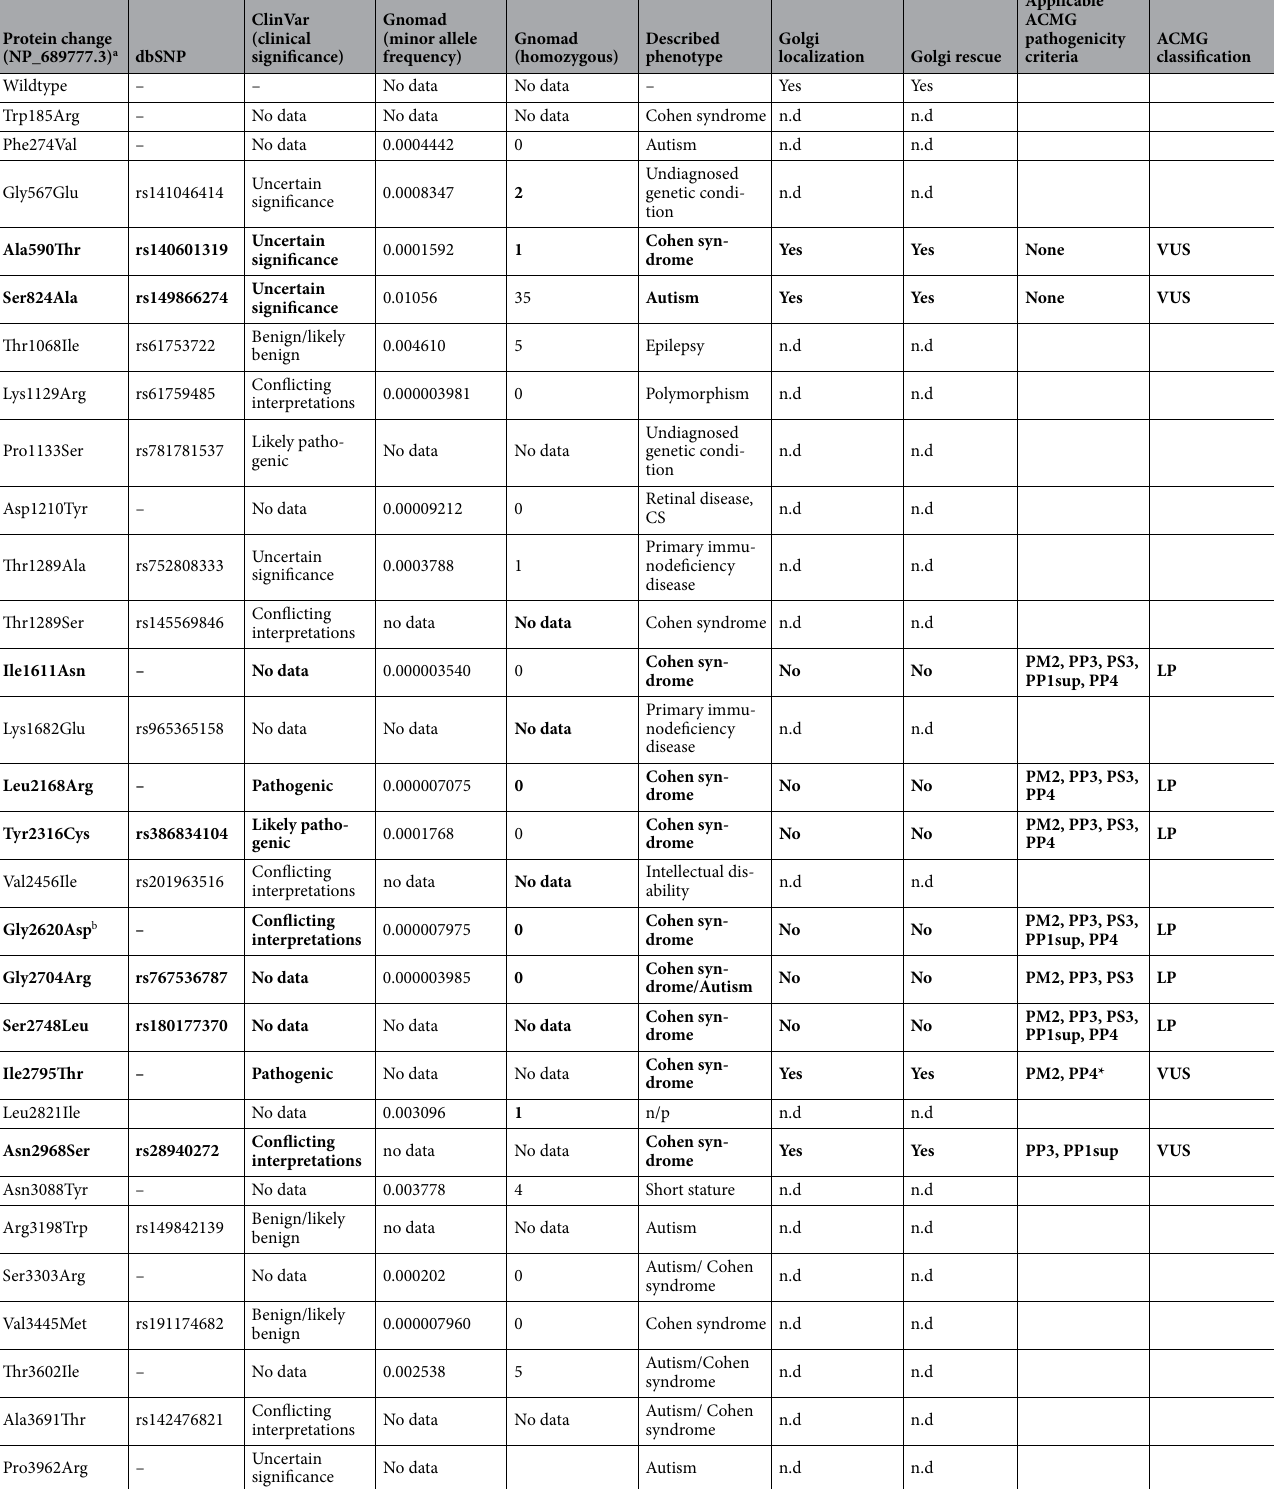
Table 1. Summary of results from in vitro characterization of the hitherto cloned VPS13B missense variations and update on ACMG classification. Missense variants in bold were cloned and tested for Golgi localization/ rescue and further reclassified according to ACMG guidelines. a Conservation of the affected amino acids is given in Supplementary Table T2. b Missense variant in combination with consanguineous homozygous loss-of- function variant; n.d. not